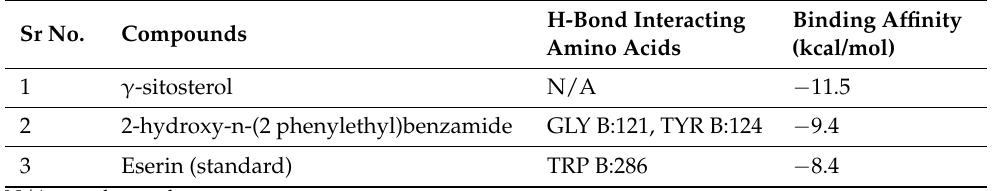
Table 7. The binding affinity of GC–MS compounds and bond interaction with acetylcholinesterase. Sr No.